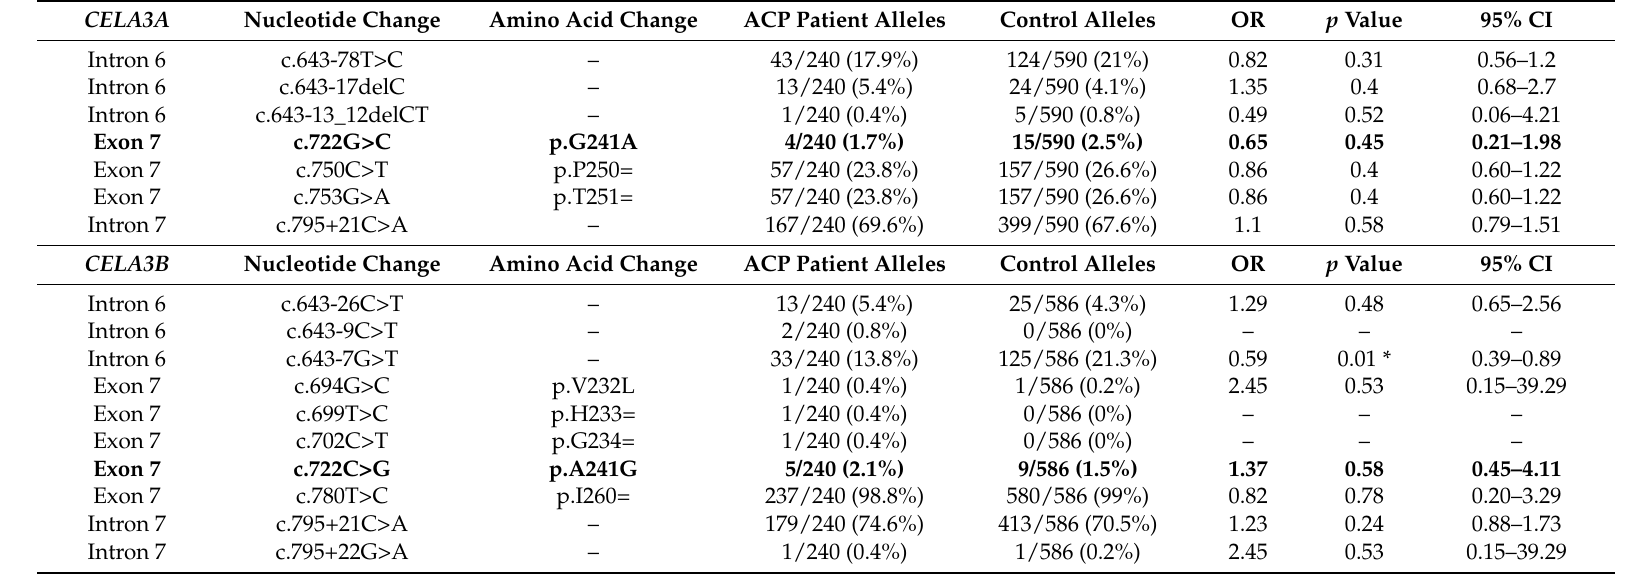
Table 2. Allele frequency of CELA3A and CELA3B variants in patients with alcoholic chronic pancreatitis (ACP) and controls without pancreatic disease. Variants affecting position 241 are highlighted in bold. OR, odds ratio; CI, confidence interval. Asterisk indicates significant